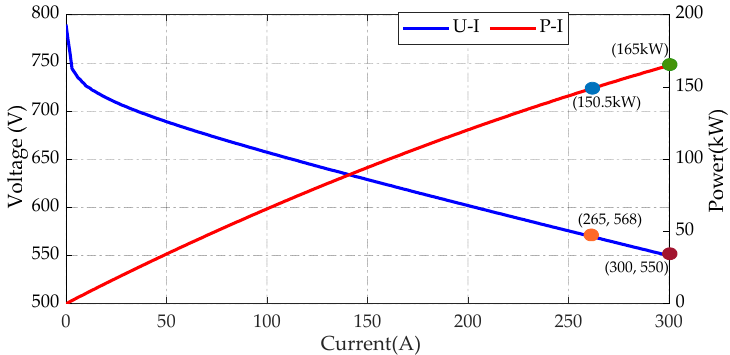
Figure 2. Polarization curves of the PEMFC stack.